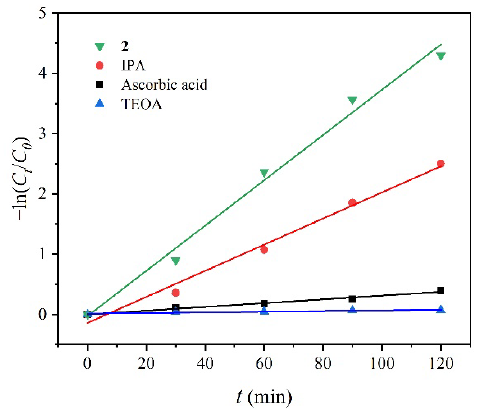
Figure 5. The pseudo-first order kinetic curves at varied photodegradation time with different radical trapping agents.